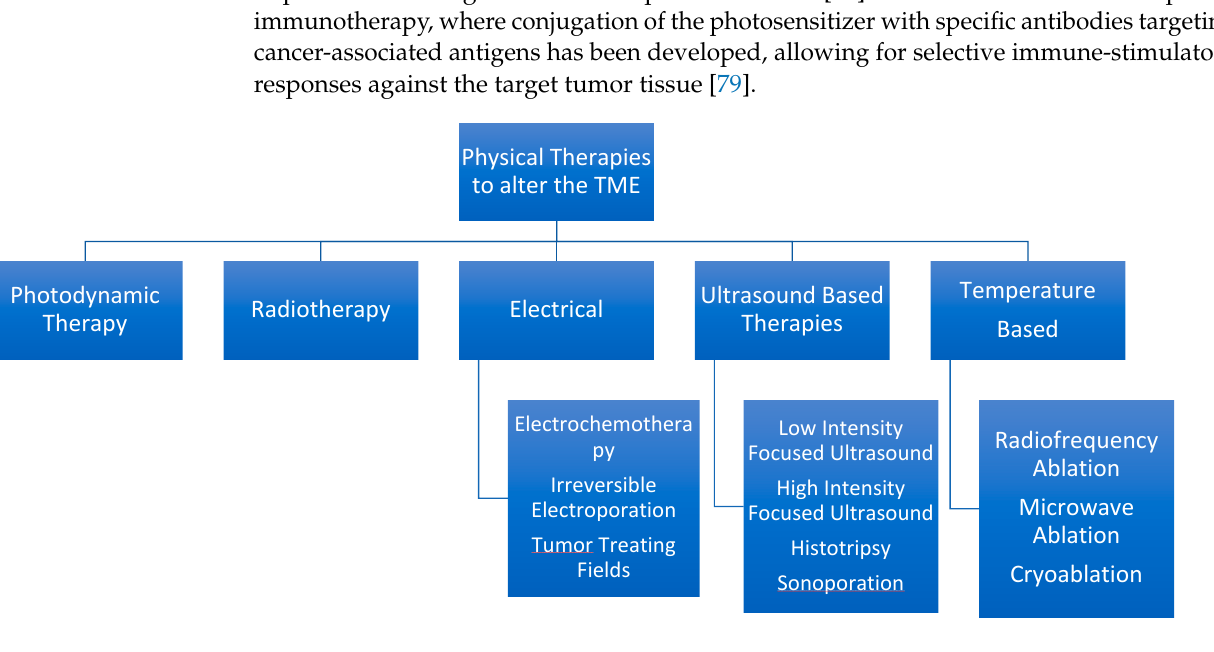
Figure 2. Hierarchal Chart to Describe various physical therapies available from a minimally inva- sive standpoint.